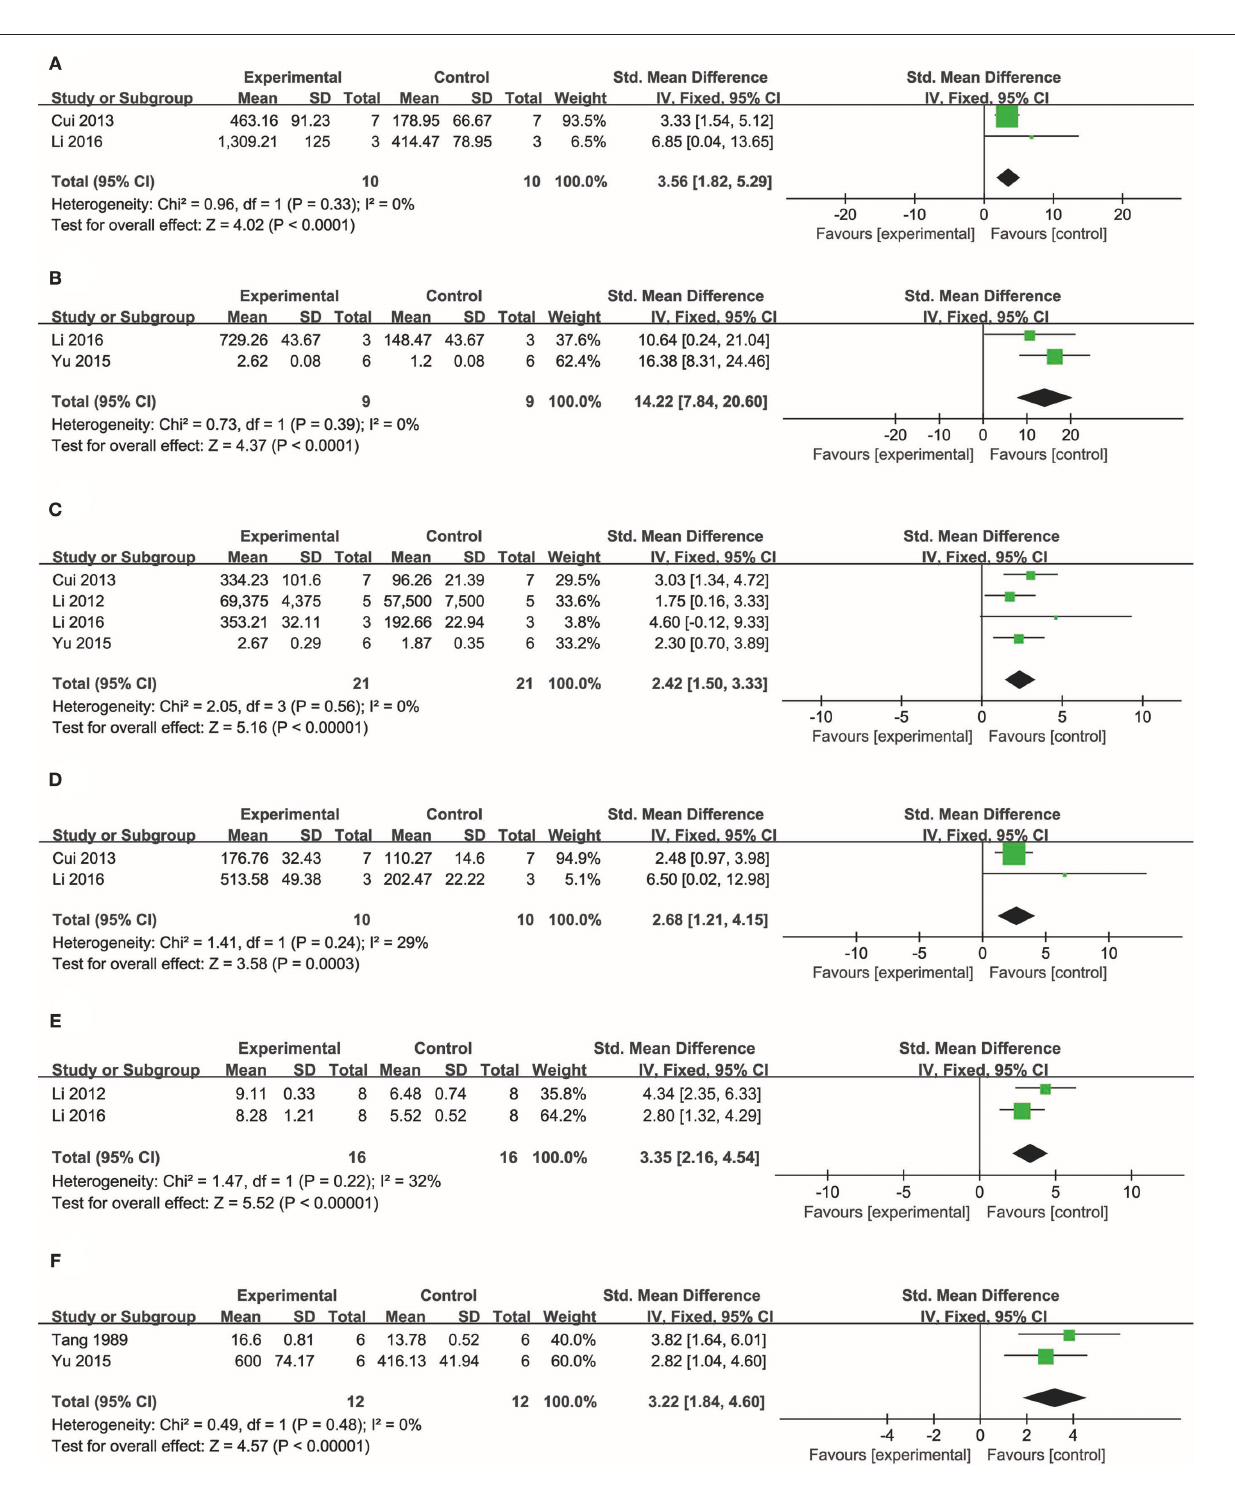
FIGURE 3 | The forest plot: (A) in vivo effects of danshensu for increasing p-PI3K compared with controls ( n = 10 per group); (B) in vivo effects of danshensu for increasing p-AKT compared with controls ( n = 9 per group); (C) in vivo effects of danshensu for increasing Nrf2 compared with controls ( n = 21per group); (D) in vivo effects of danshensu for increasing HO-1compared with controls ( n = 10 per group); (E) in vivo effects of danshensu for increasing GST compared with controls ( n = 16 per group); (F) in vivo effects of danshensu for increasing GSH-Pxcompared with controls ( n = 12 per group). p-PI3K, phosphatidylinositol 3-kinase; p-AKT, phosphothreonine kinase; Nrf2, nuclear factor erythroid 2-related factor 2; HO-1, heme oxygenase-1; GST, glutathione-S-transferase; GSH-Px, glutathione peroxidase.